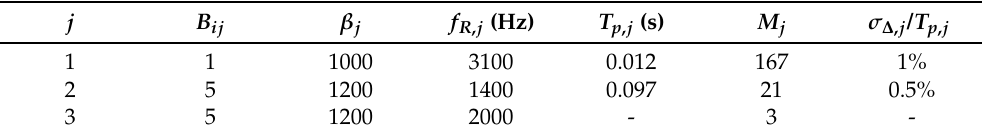
Table 1. Parameters of the simulation